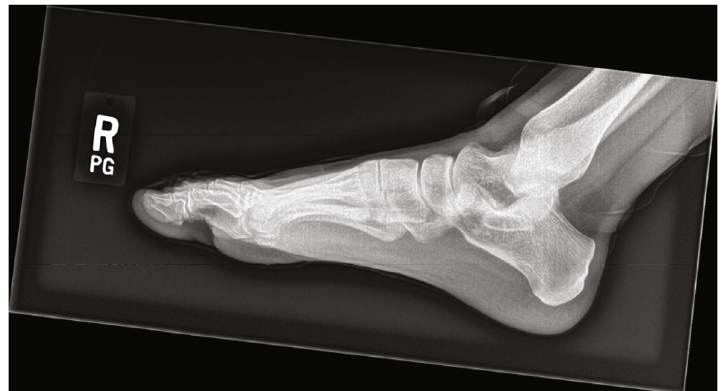
Figure 9: Lateral radiograph of the right foot taken three years post-OCA implantation with complete resolution of hallux rigidus.